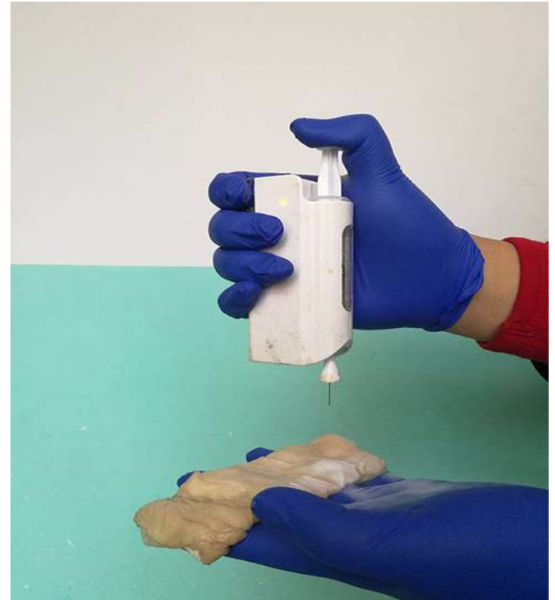
Figure 11. Implementing the portable ES device in an intestinal incision. With permission from ref. [192].